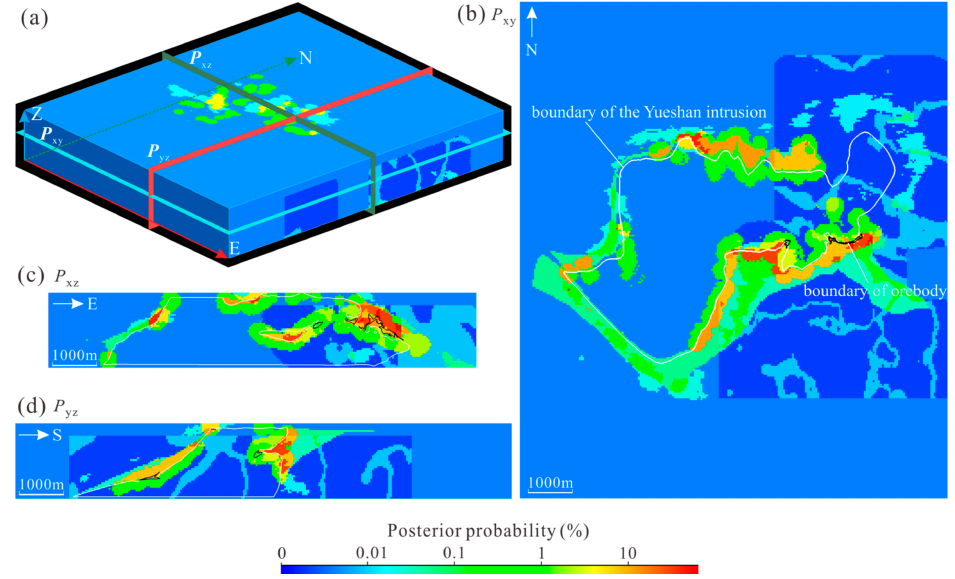
Figure 13. ( a ) 3D posterior probability map, partly showing the cross-section view, ( b ) P xy , view from top, ( c ) P xz , view from south; ( d ) P yz , view from